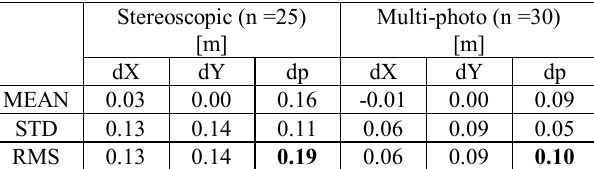
Table 3. Accuracies of photogrammetric methods compared